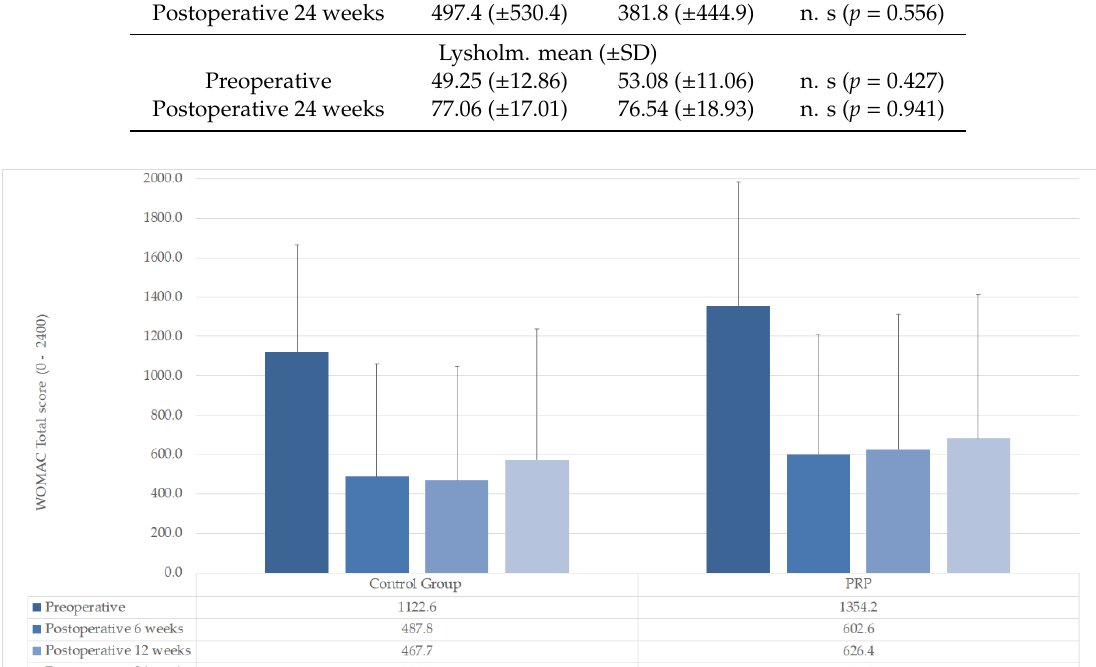
Figure 3. Preoperative vs postoperative total WOMAC score.